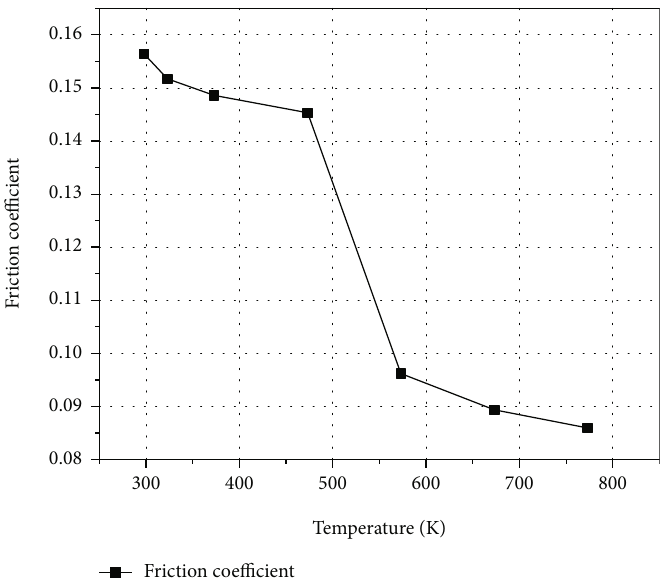
Figure 2: Friction coe ffi cient of di ff erent temperature.